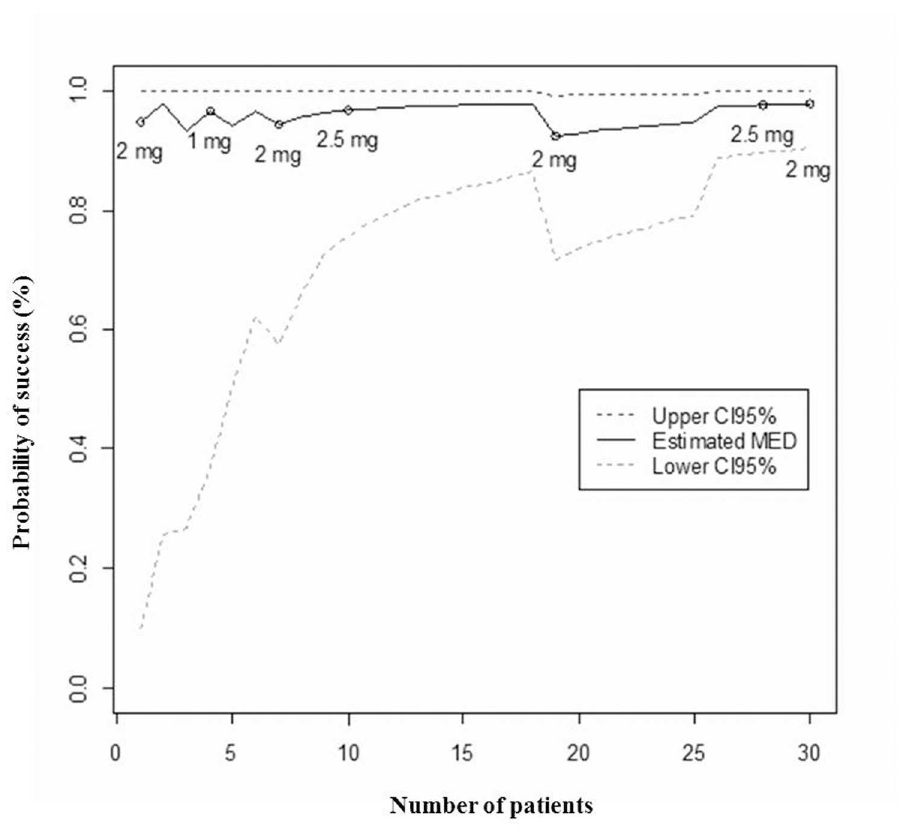
Fig 2. Mean posterior probability of successrelated to the minimum effectivedose and its 95% credibility interval according to patients’ inclusions for the group of neonates born below 32 weeks of gestational age. CI95%: 95% credibililtyinterval. MED: Minimum Effective